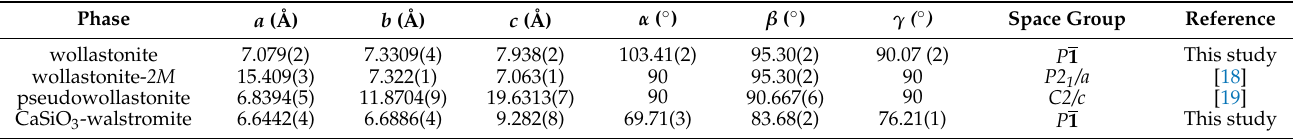
Figure 2. Crystal structure of ( a ) wollastonite, ( b ) wollastonite- 2M , ( c ) pseudowollastonite, and ( d ) breyite. The representations of the structure are realized using the program VESTA [17]. Small red spheres are oxygens, (SiO 4 ) 2 − are blue tetrahedra and grey polygons are Ca cation sites. Black solid lines represent the dimension of the unit cell. Table 1. Unit-cell constants of CaSiO 3 system up to ca. 8 GPa.